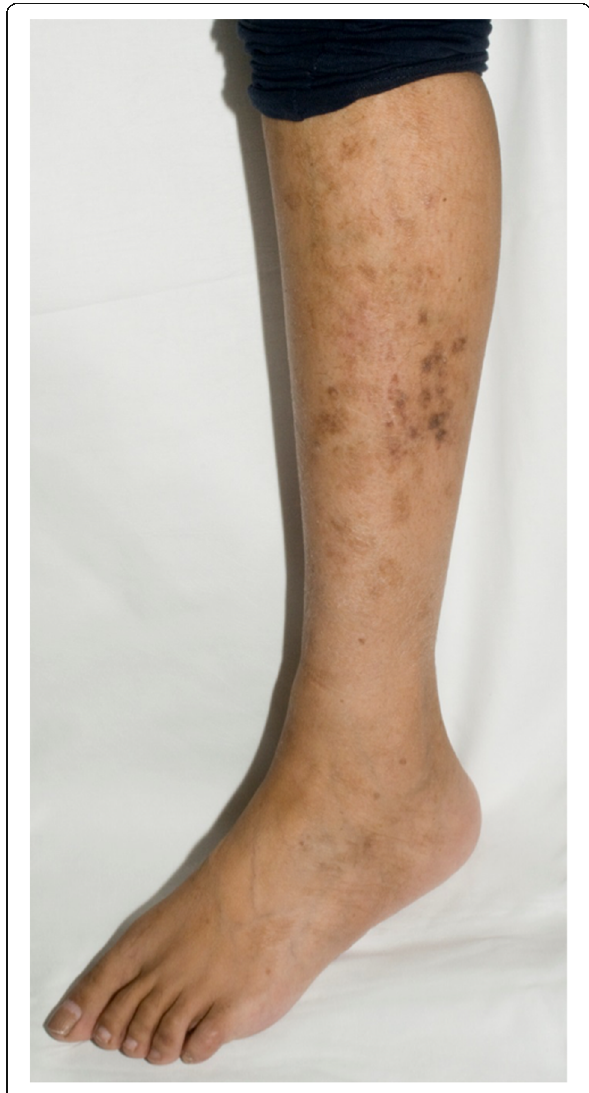
Fig. 2 Photograph of the proband ’ s left leg showing café-au-lait lesions on a background of lichen planus